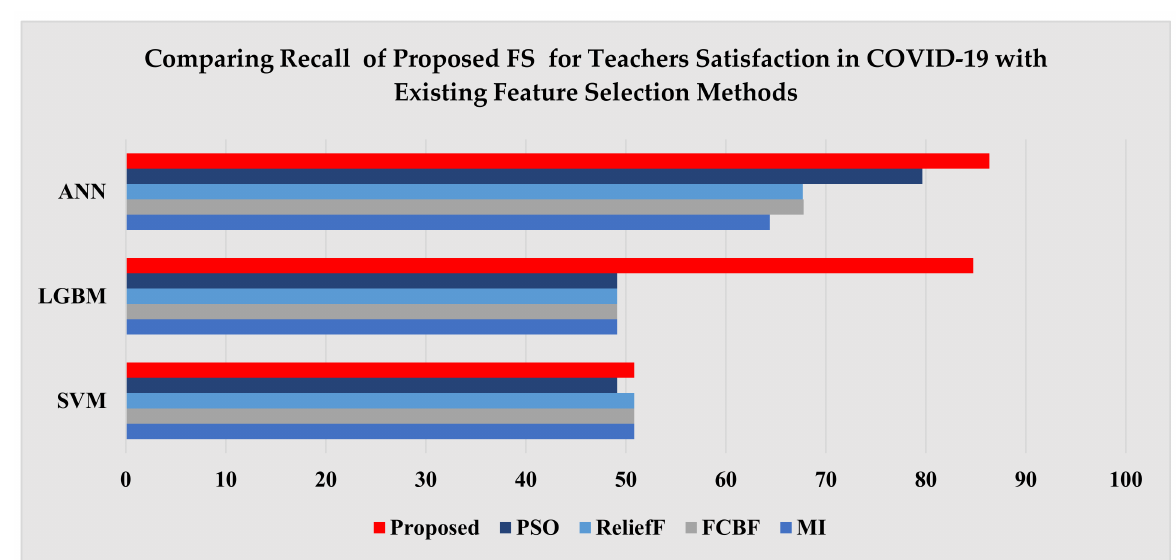
Figure 5. Recall Comparison of Proposed FS for Teachers Satisfaction in COVID-19 with Existing Feature Selection Methods.